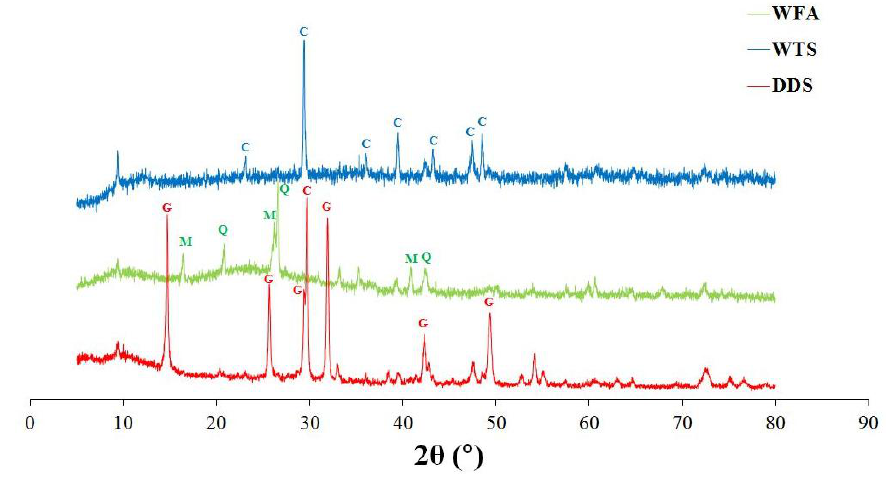
Figure 4. XRD analysis results for the three coal combustion residues (C = Calcite; M = Mullite; Q = Quartz; and G = Gypsum).